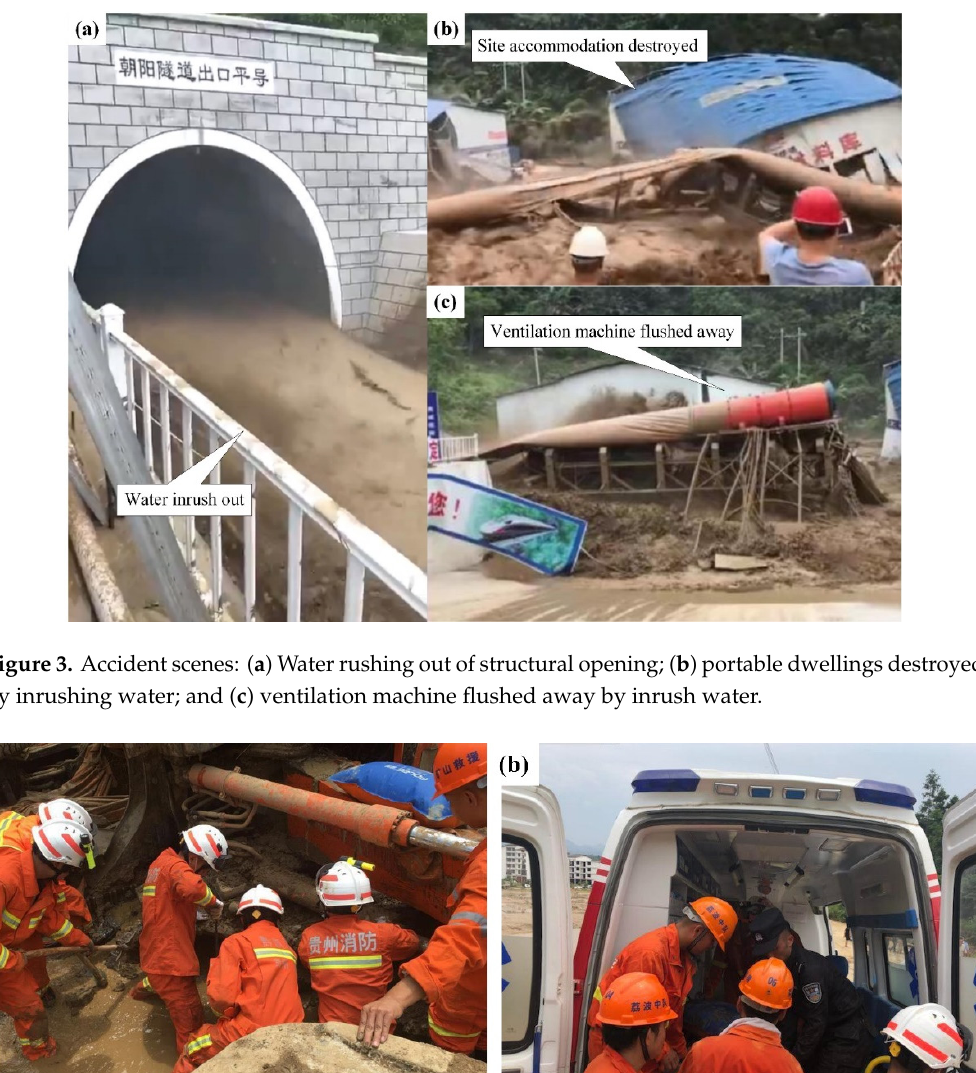
3 of 11 Figure 2. Construction situation ( a ) inside and ( b ) outside the tunnel before the incident. 3. Water Inrush Incident and Rescue Operation 3.1. Water Inrush Incident At 4:40 a.m. on 30 May 2018, a muddy water ejection from the bottom plate with increasing pressure occurred during the drilling operations on the tunnel face. As a result, the excavation was temporarily stopped, and exploratory drilling was conducted to decipher the geologic conditions and trend of the water-eroded groove in front of the tunnel face. The surrounding rocks of the tunnel face were observed daily to ensure the stability of future excavation operations. Nevertheless, at 8:30 a.m. on 10 June 2018, a non-pressure water leakage was found at the early inrush points in the tunnel face. At 9:56 a.m., a heavy flood of water and mud suddenly ejected out (as shown in Figure 3), and the water level reached a maximal height of 2.5 m above the bottom plate. An excavation bench (1800 m